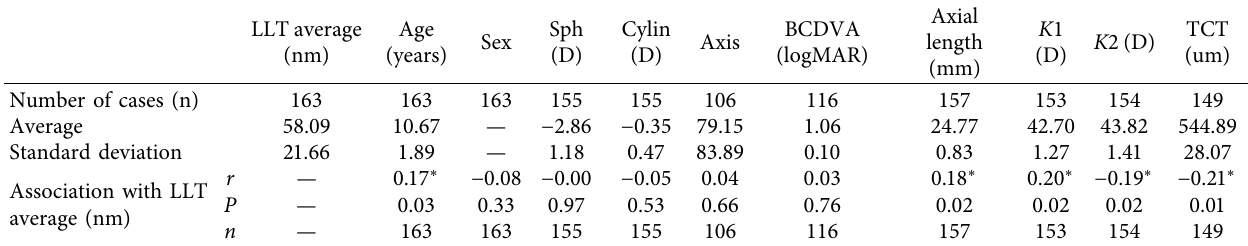
Table 2: Correlation of LLT (average) and other clinical variables of 163 eyes at